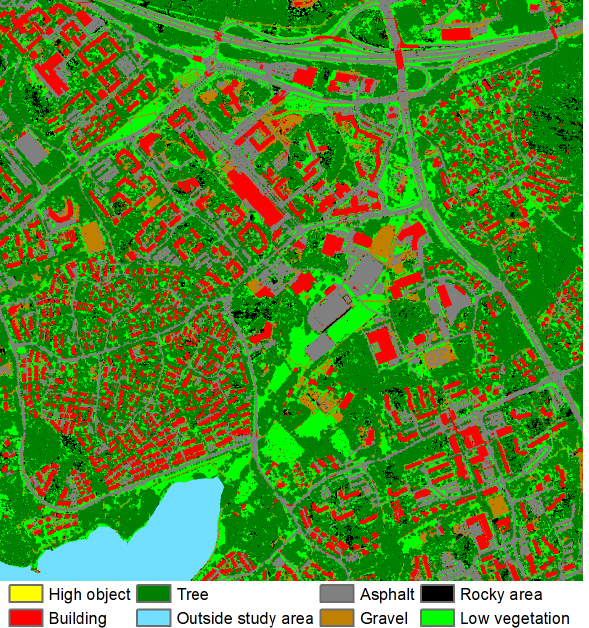
Figure 5. Result of land cover classification (class High object includes a few very small segments that remained unclassified in further building / tree classification).